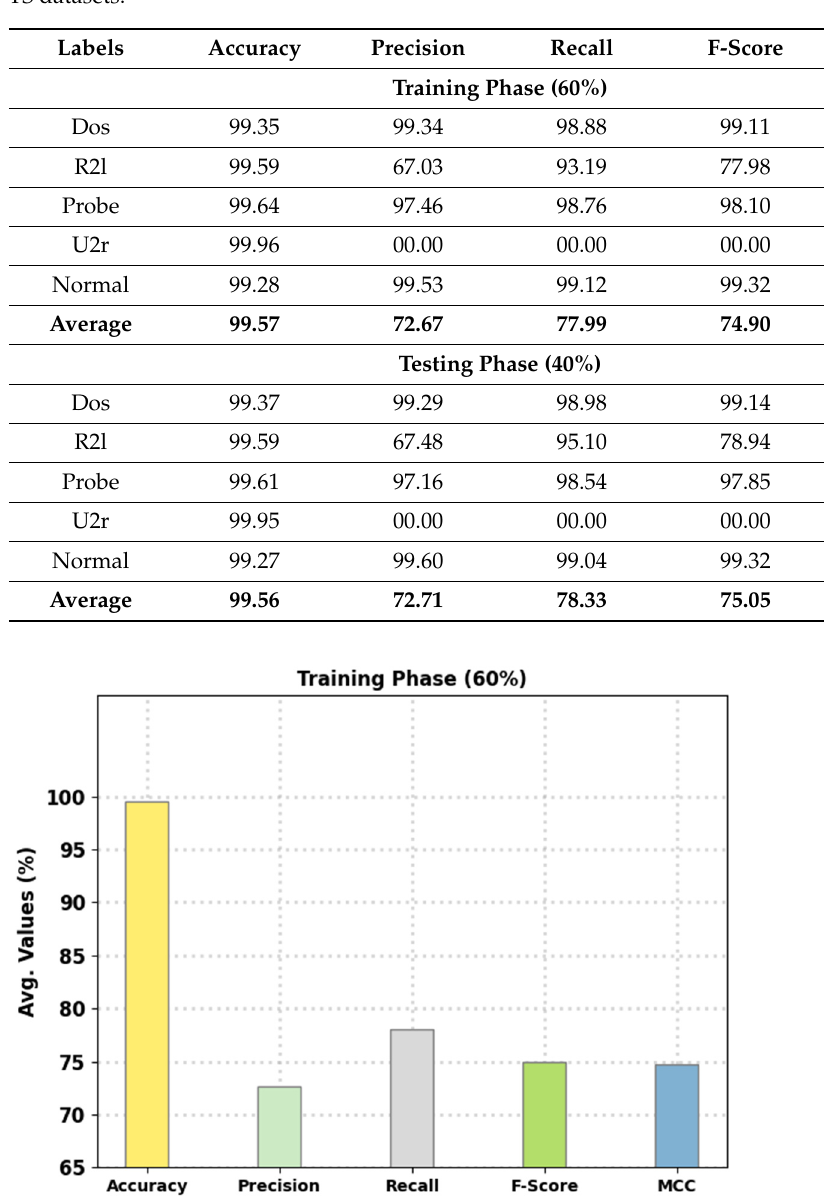
Figure 4. Average analysis of FSHDBN-CID approach under 60% of TR dataset.